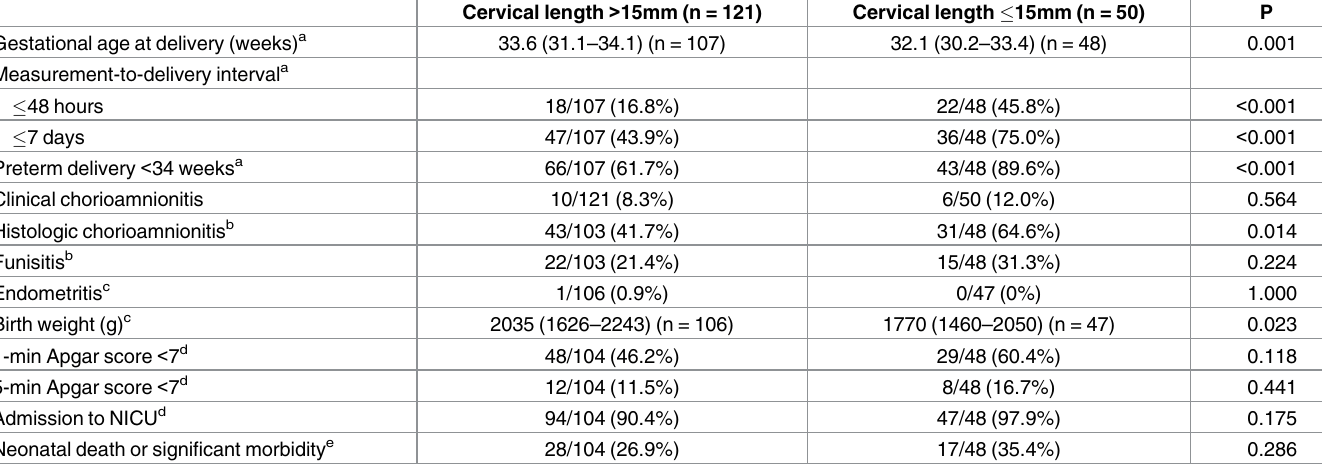
Table 2. Pregnancy and neonatal outcomes according to the presenceor absence of a short